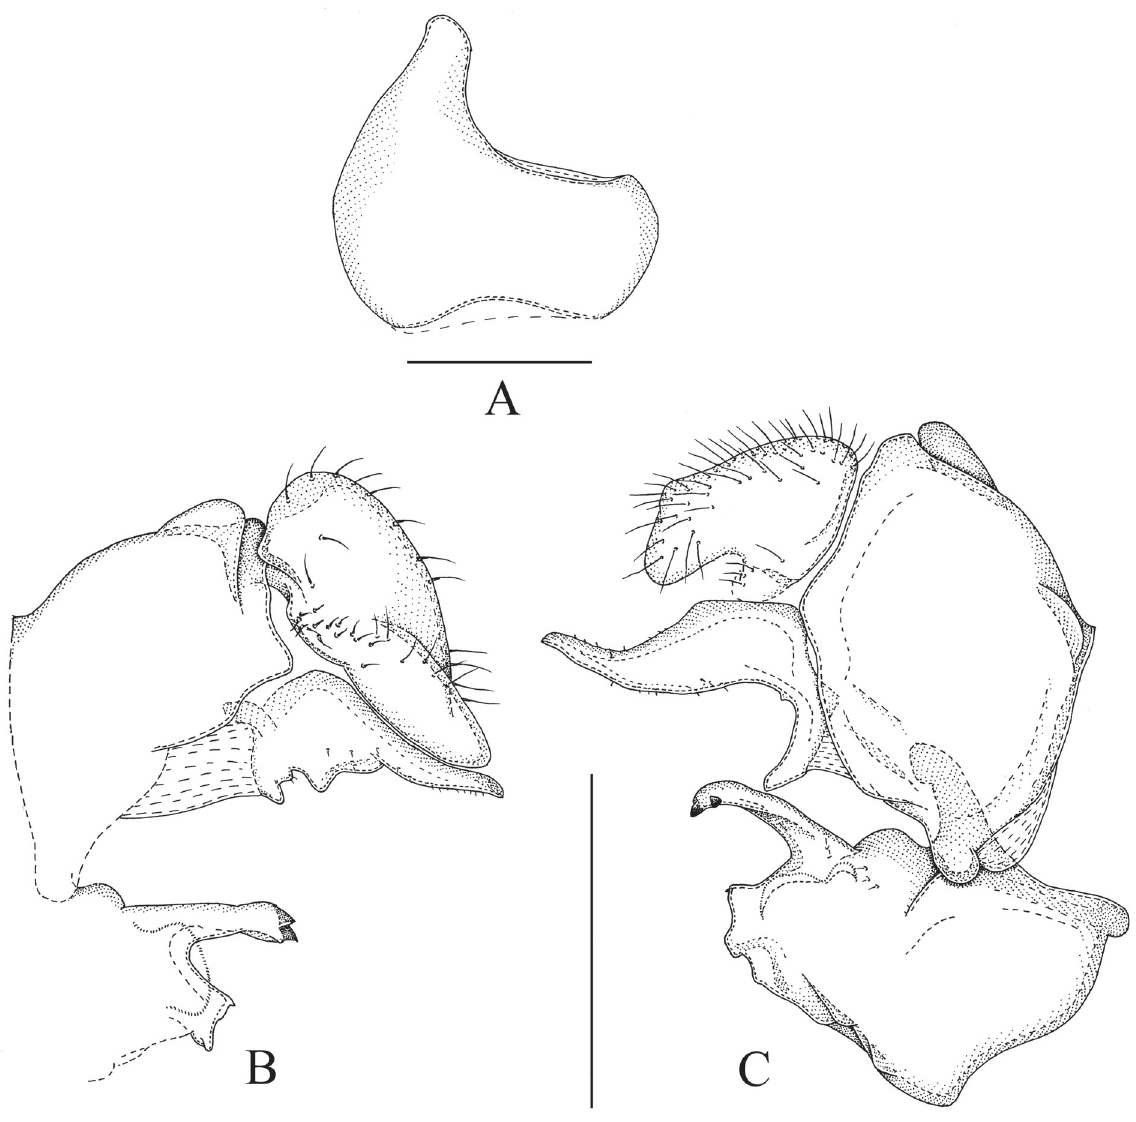
Fig. 51. Sphegina (Asiosphegina) javana de Meijere, 1914, paralectotype, ♂ . A . Sternum IV, ventral view. B . Genitalia left side, lateral view. C . Genitalia right side, lateral view. Scale bars = 0.5